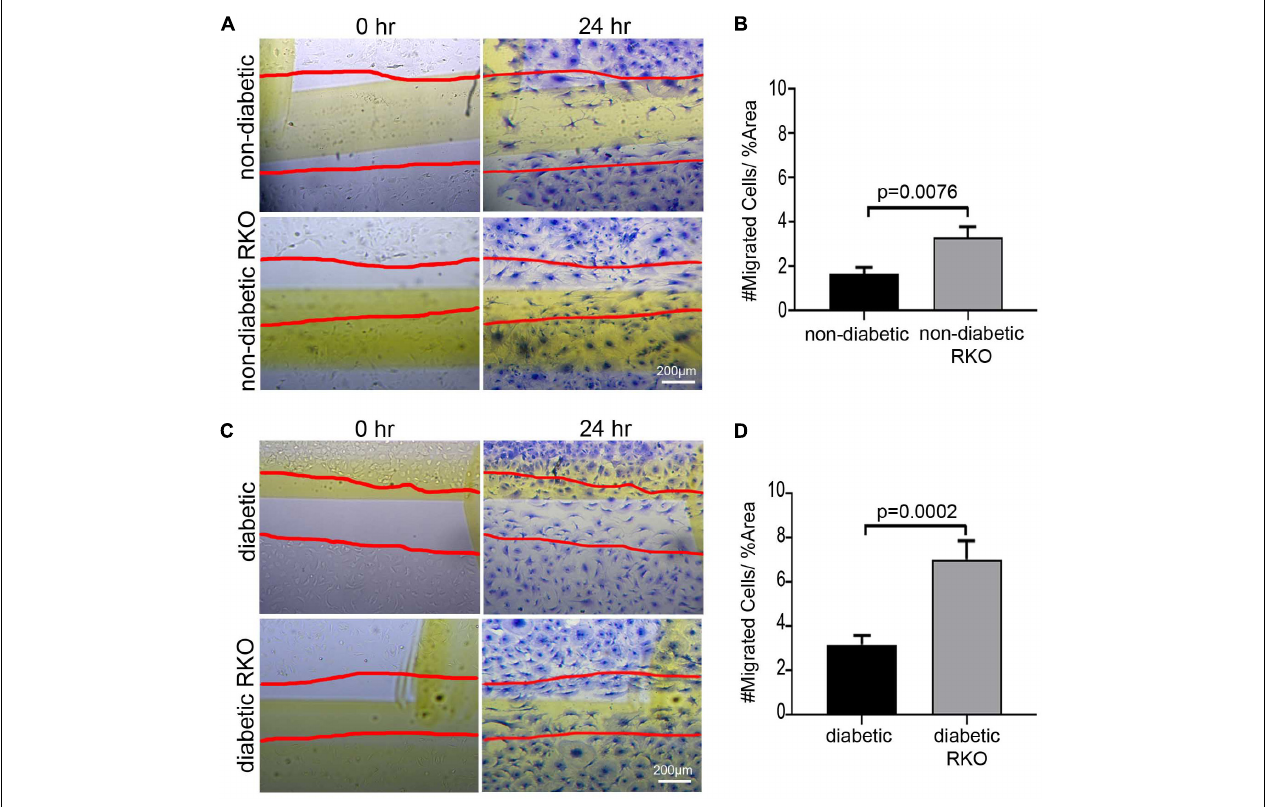
FIGURE 1 | The presence of RAGE signaling negatively impacts cardiac fibroblast migration. Cardiac fibroblasts were isolated from (A,B) non-diabetic with and without RAGE mice as well as (C,D) diabetic with and without RAGE mice. Fibroblasts were plated onto plastic cell culture dishes, scratched (0 h: A,C ), and assessed for cell migration after 24 h (B,D) . Cells were stained with Coomassie for visualization with the red lines depicting scratched area (40 × and scale bar = 200 µ m). Number of migrated cells were normalized to percent scratched area and plotted as mean ± SEM ( n = 7–13). Student’s t -test used to determine significance, which is depicted on